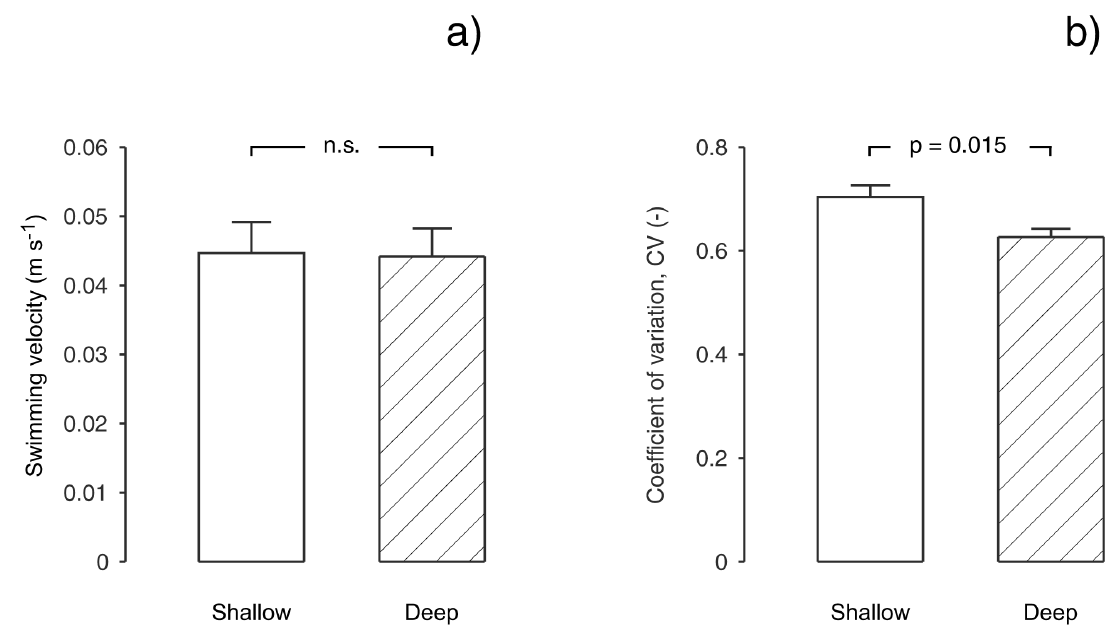
Fig. 2. Characteristics of swimming behaviour for shallow-bodied (shallow, n = 16) and deep-bodied (deep, n = 12) crucian carp. (a) swimming velocity (+1 SE, measured per individual), (b) coefficient of variation for swimming velocity (+1 SE; measured per individ- ual over the focal 5 min period). Significance levels are given above bars, n.s. denotes non-significant difference.